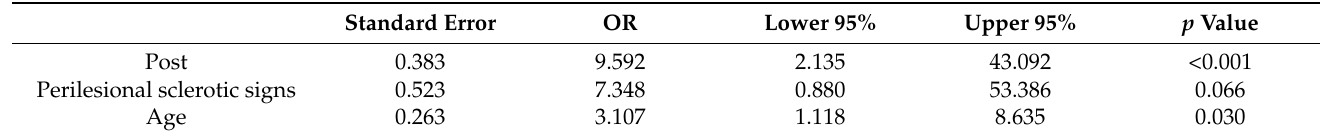
Table 3. Multivariate logistic regression model results of endodontic surgery. Standard